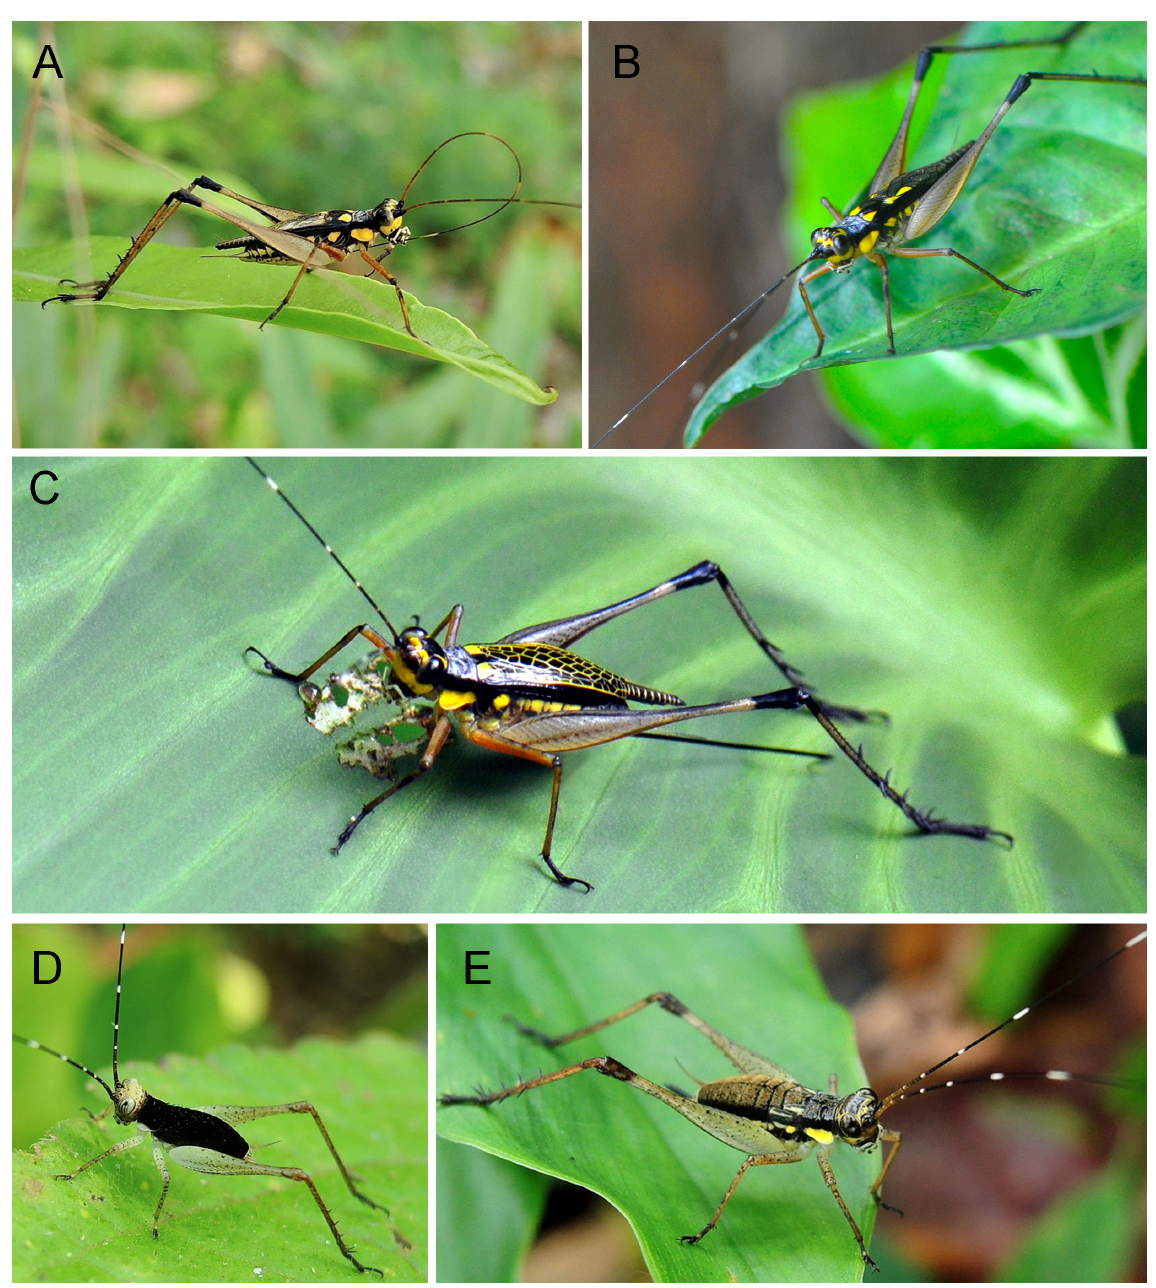
Fig. 22. Nisitrus insignis Saussure, 1878 in its natural environment. A–B . Adult ♂♂. C . Adult ♀. D–E . Nymphs. Photograph source and credits: iNaturalist; Michael Kesl (A, D–E), Oscar Johnson (B), Dries Nys and Marion Vancauwenbergh